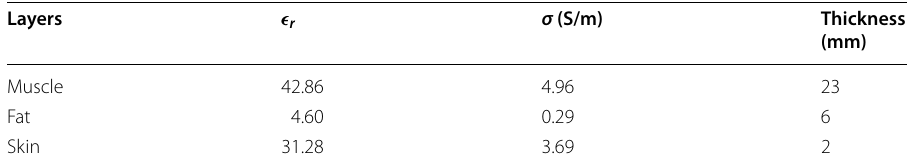
Table 4 Dielectric characteristics of human tissue at 9.8 GHz